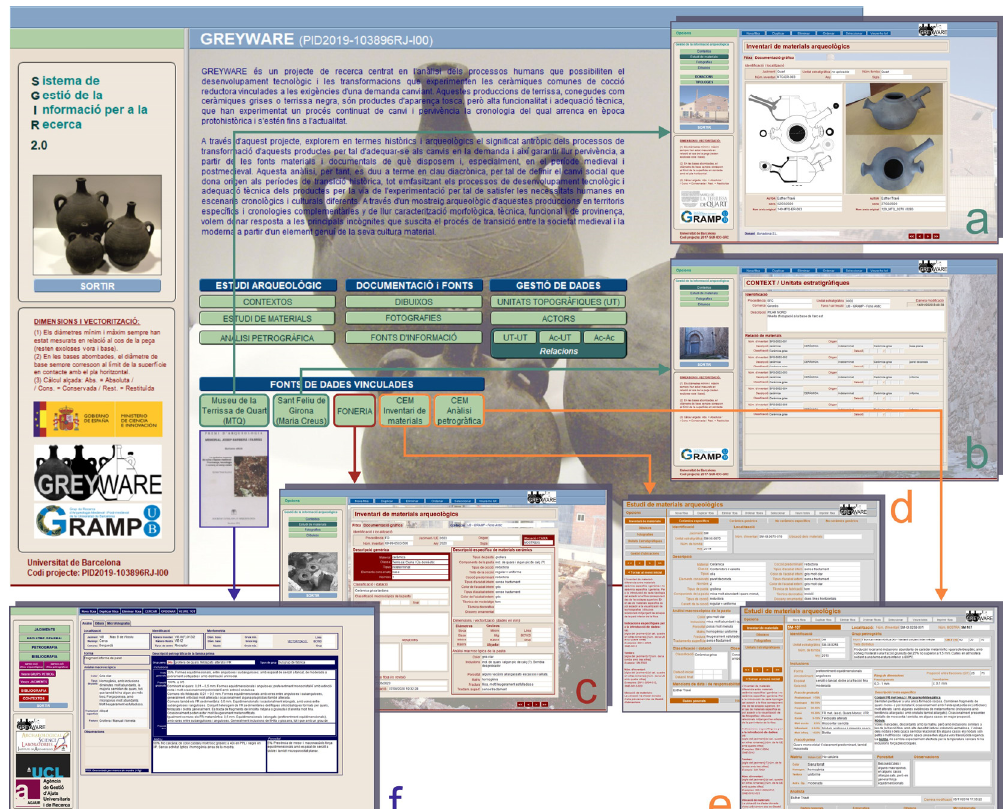
Figure 5. G REYWARE ’s database interoperability. Regardless of the database tables and interfaces, the starting screen allows access to former databases both for pottery studies and the general registering of the archaeological record at different sites. Amongst these, there is the prototype developed at the former Pottery Museum of Quart ( a ), specific one-site databases for the archaeological materials from Saint Felix Church (Girona, Spain) ( b ) and the Smiths Guild ‘La Foneria’ (Barcelona, Spain) ( c ); databases shared with the Centre d’Estudis Martorellencs, a local association for cultural studies ( d , e ); and a former research project on medieval greyware ceramics ( f